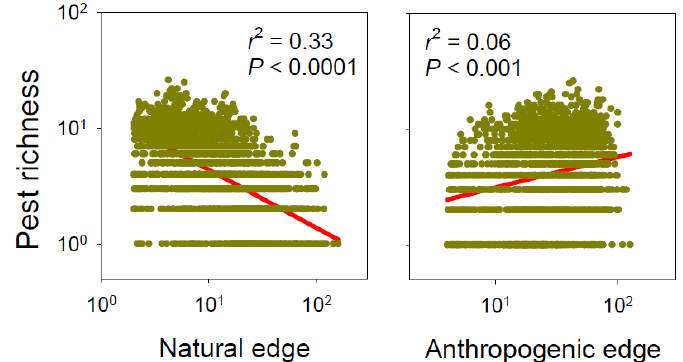
Figure 3. Effects of natural and anthropogenic forest edges on nonnative pest richness across the forests in the conterminous continental United States ( N = 2098 counties).